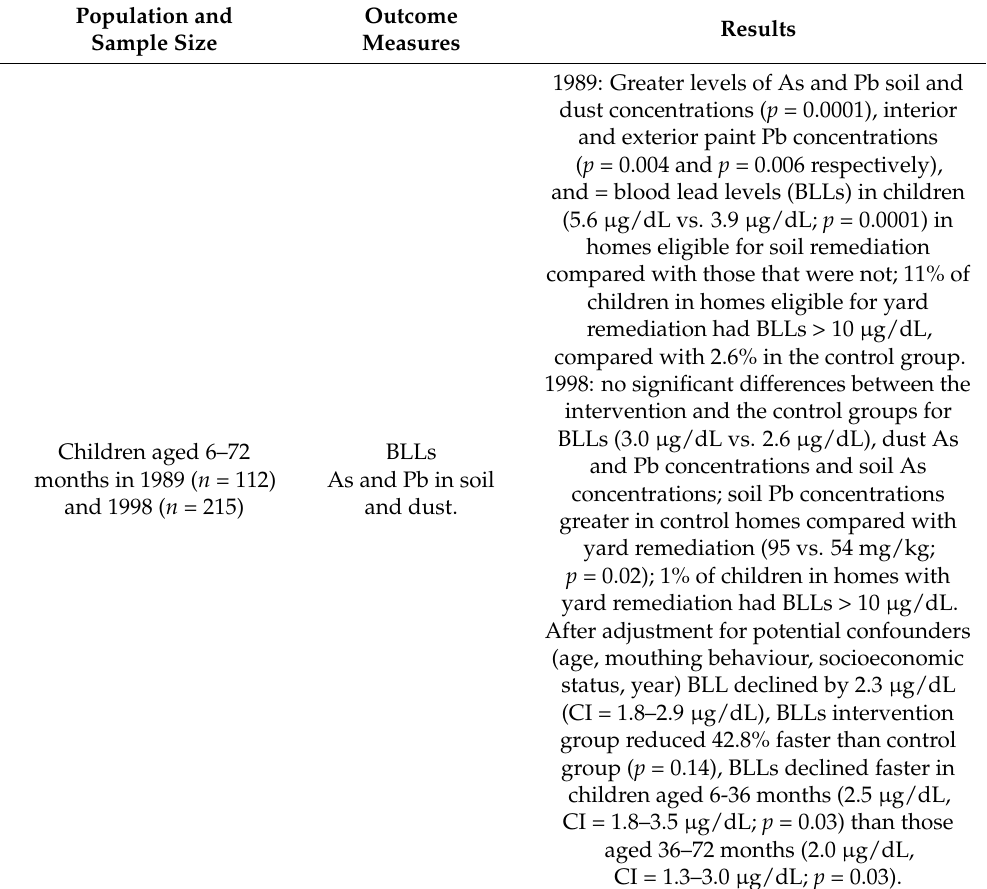
Table 5. Studies reporting health-related outcomes for people living near contaminated sites after